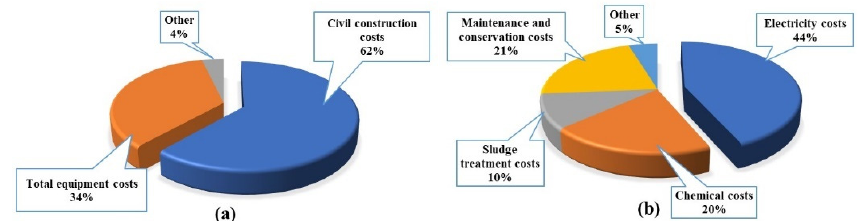
Figure 6. One-stage SNDA process cost analysis; ( a ) distribution of total project investment; ( b ) distribution of operating costs.